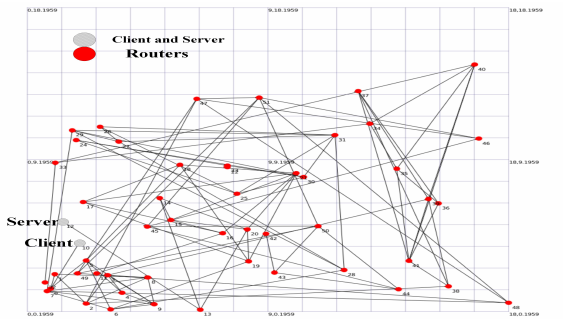
Figure 7: Sample ns-3 Topology Consists of 100 Nodes